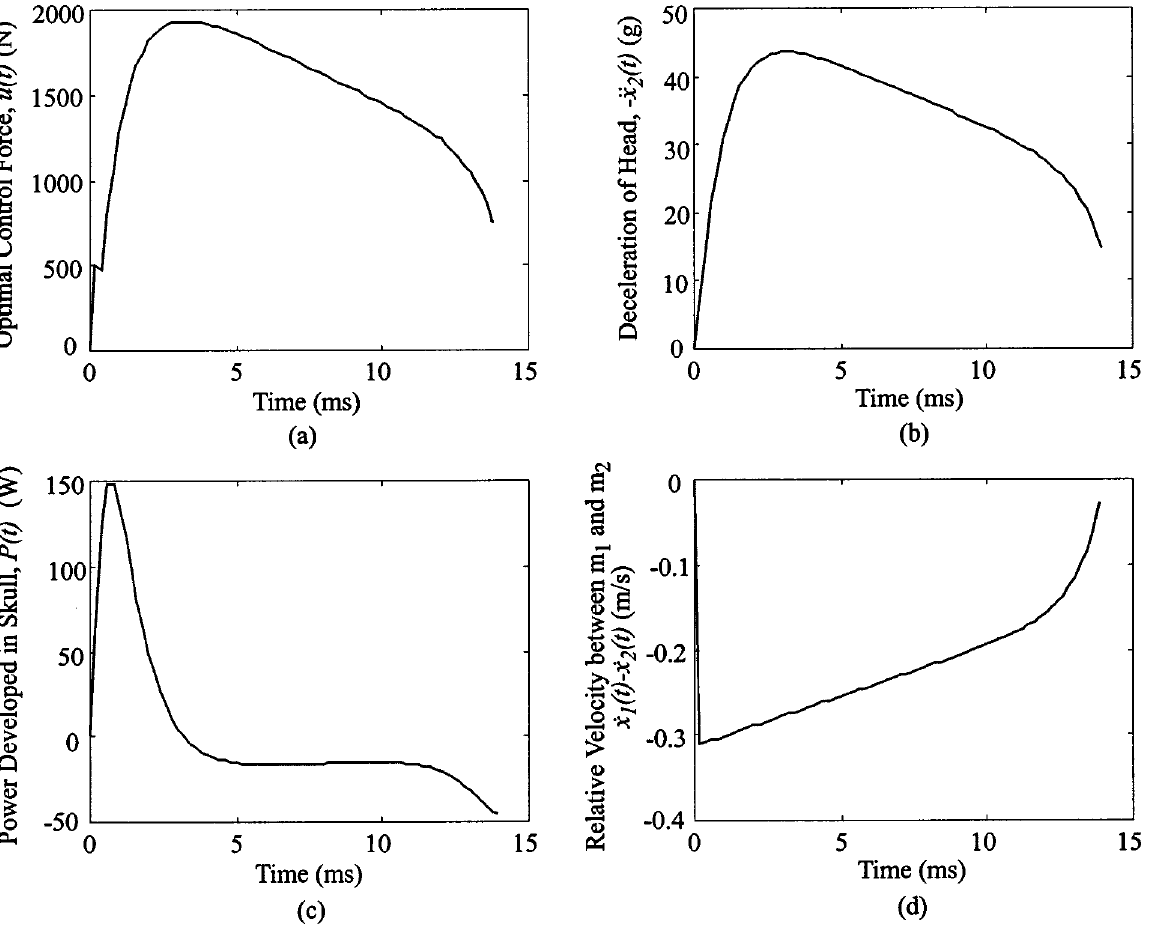
Fig. 12. Optimal control force and system responses. Case 2: Minimize the energy imparted to the brain, S 0 = 30 mm, E 0 = 53 : 4 J, L–R direction. (cid:15) There are significant differences among the ener- gies imparted to the brain, especially when the rat- tlespace is small, for different impact